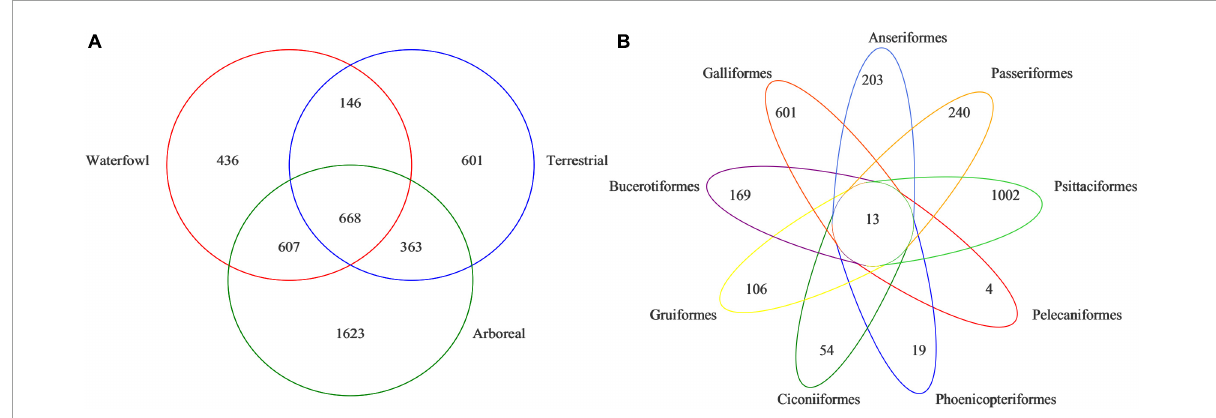
FIGURE1 Venn diagram showing overlap/non-overlap of operational taxonomic units (OTUs) between the (A) three ecological types and (B) nine orders.